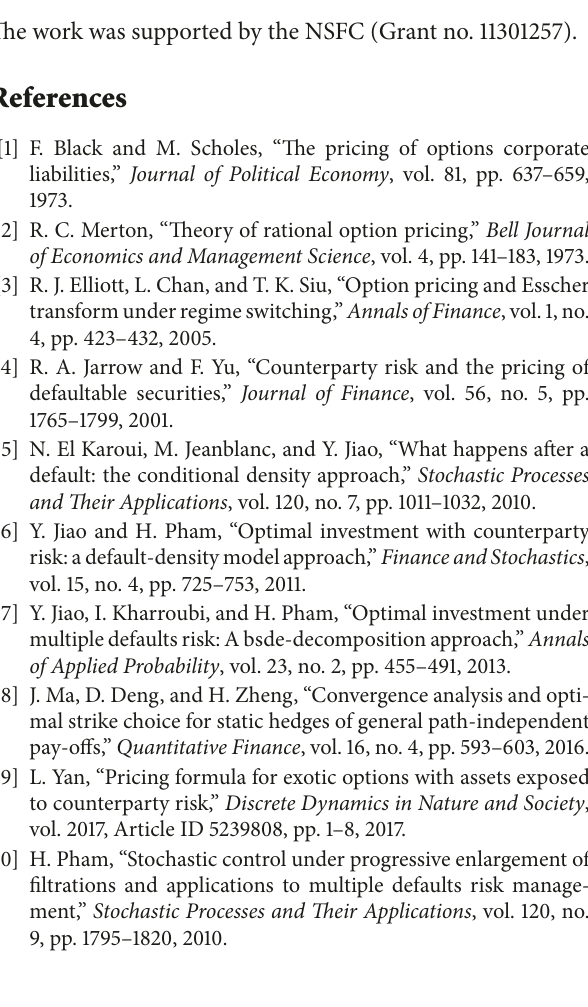
= 0.2, 𝜎 = 0.4 , and 1 2